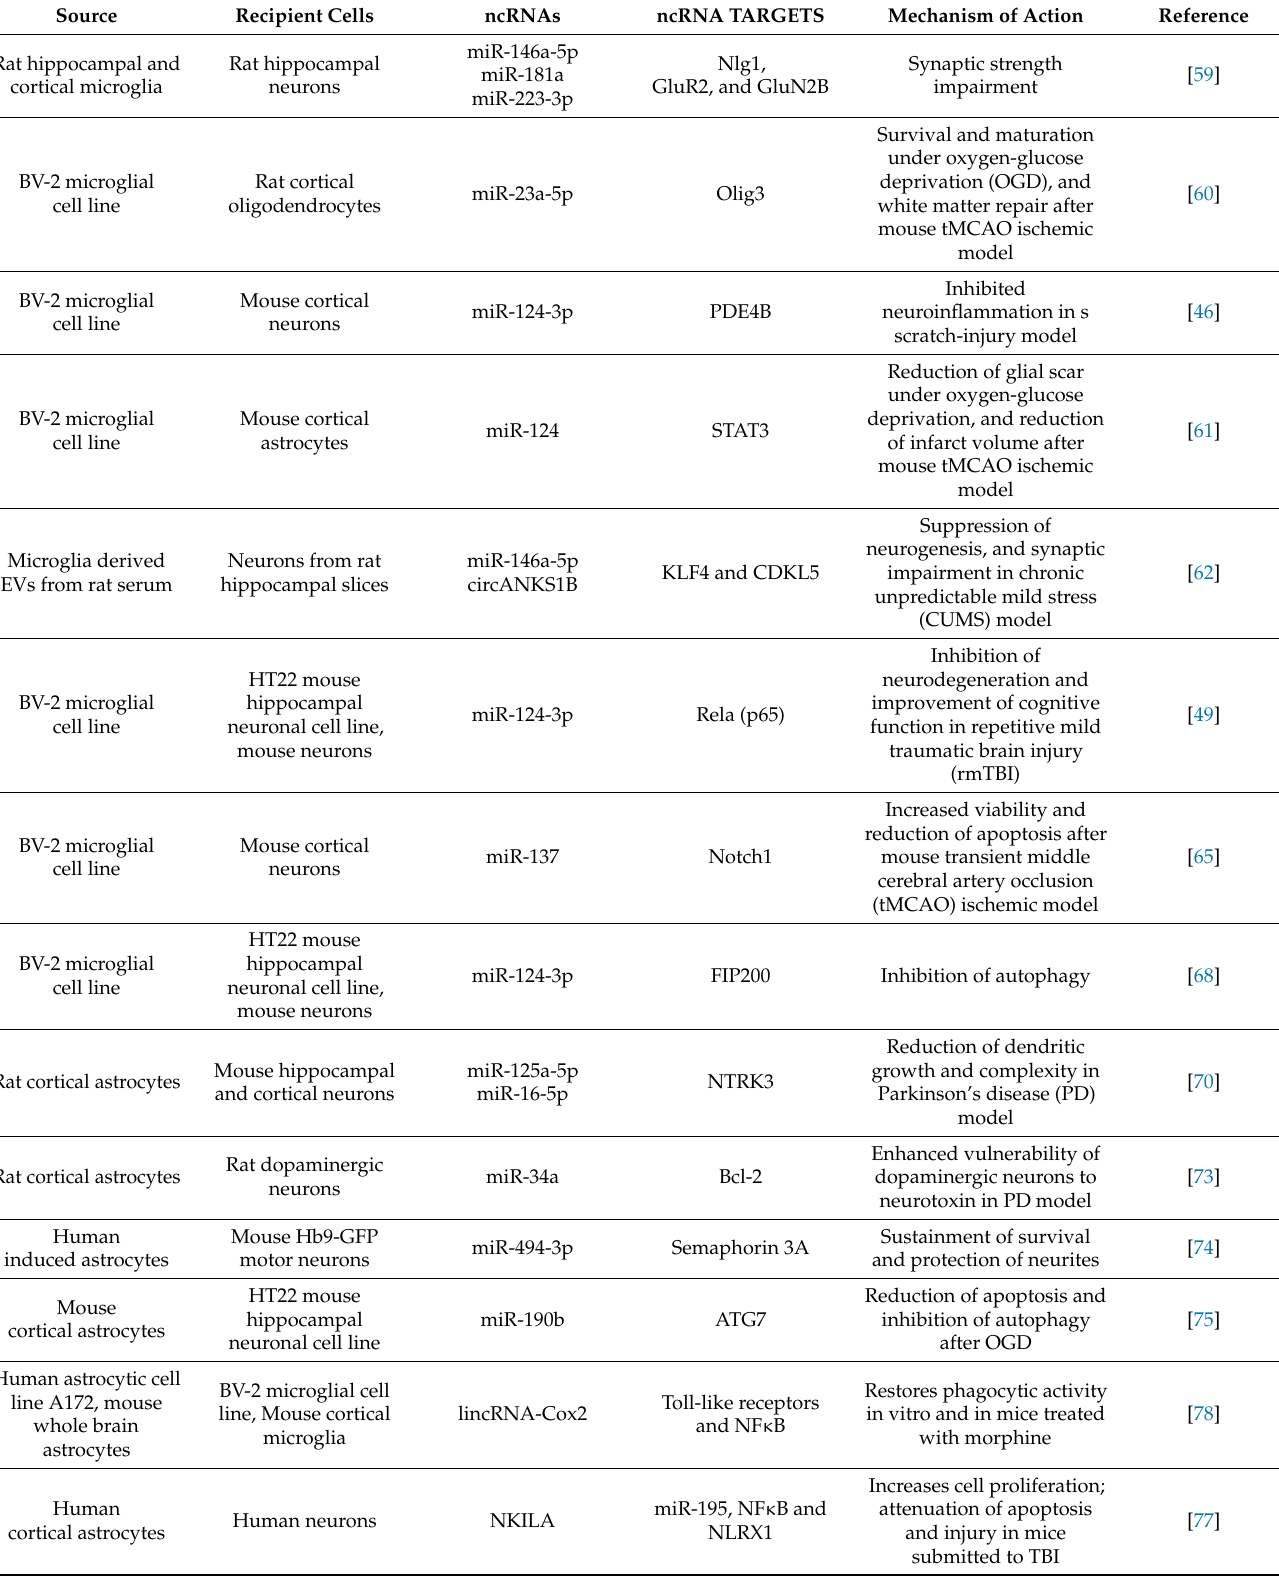
Table 2. Summary of glial EV-derived ncRNAs, their targets, and